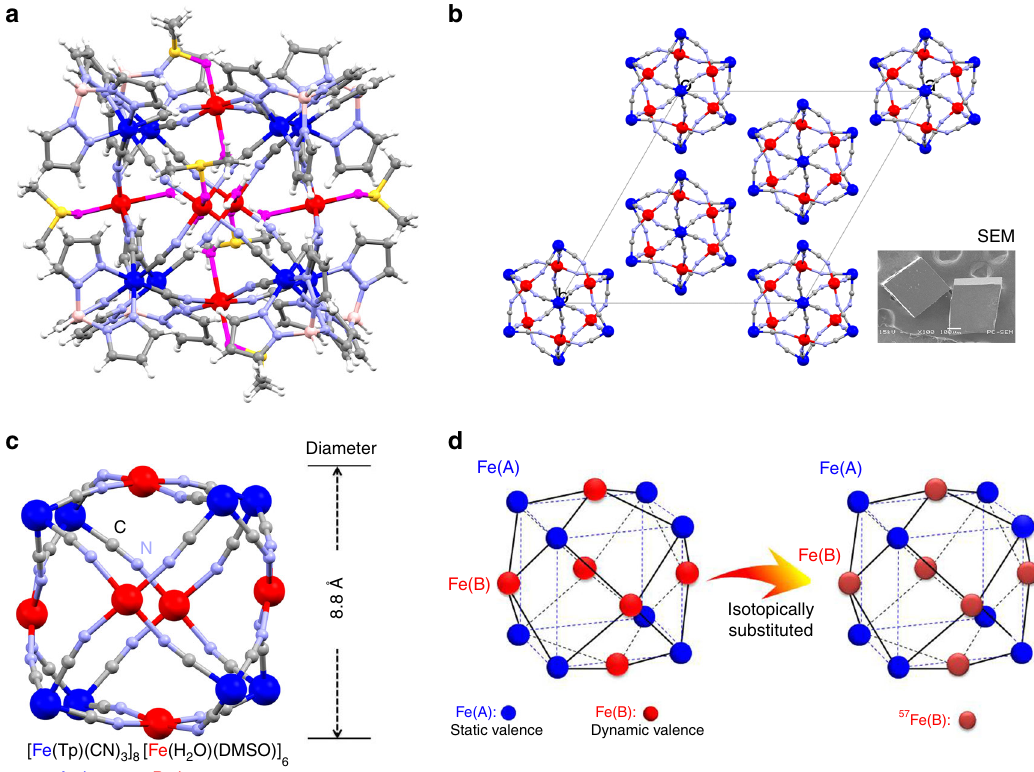
Fig. 1 X-ray crystal structure determination. a Complete structure of the [Fe 14 ] spherical complex in a ball-and-stick style. The valence state on different Fe sites is indicated by two-color systems, that is, A-site Fe (blue) and B-site Fe (red), and O (pink), S (yellow), N (purple), C (gray), and H (white). b View of the cubic packing of the simpli fi ed [Fe 14 ] complex along the crystallographic c -axis. The inset denotes the scanning electron microscope (SEM) image of a single crystal of [Fe 14 ], illustrating the cubic faces. c The simpli fi ed [Fe 14 ] atomic layer framework with a diameter of 8.8 Å. d B-site-selective isotope substitution in the